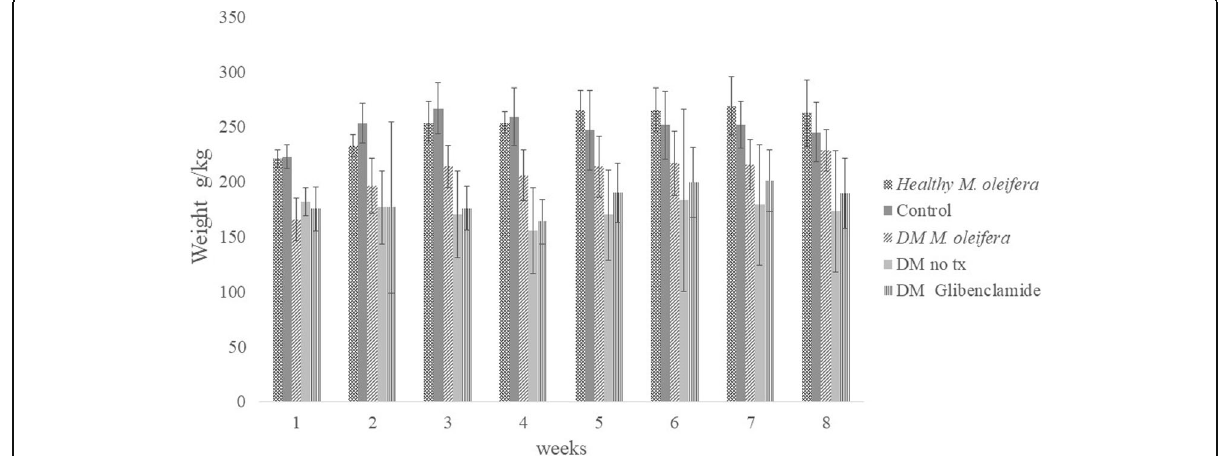
Fig. 3 Weight (g/kg) of study groups during 8 weeks. Data are expressed as mean ± standard deviation per group